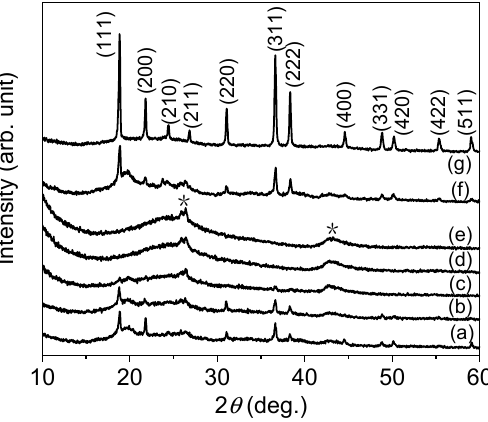
Figure 1. Wide-angle XRD patterns of the prepared Ba-Ru catalysts and reference materials—( a ) 1.6Ba-10Ru/MPC, ( b ) 1Ba-10Ru/MPC, ( c ) 0.5Ba-10Ru/MPC, ( d ) 0.1Ba-10Ru/MPC, ( e ) 10Ru/MPC, ( f )